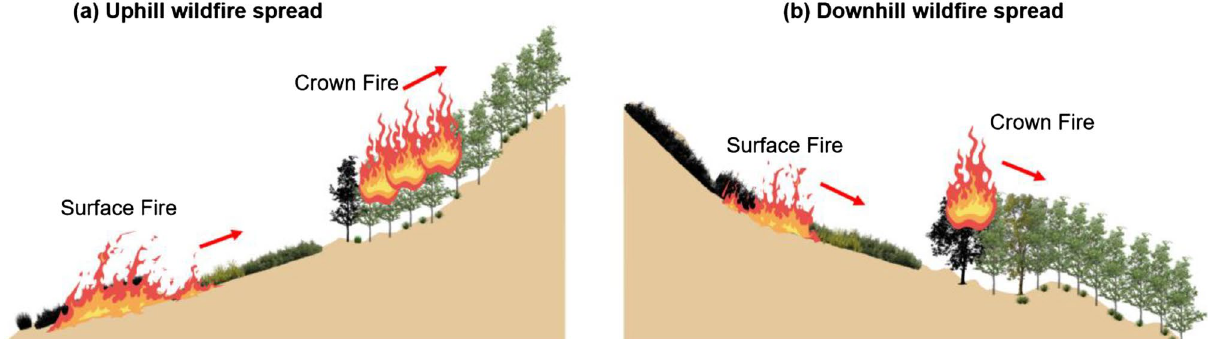
Figure 12. Illustration of wildfire spread: ( a ) uphill fire spread and ( b ) downhill fire spread (copyright: